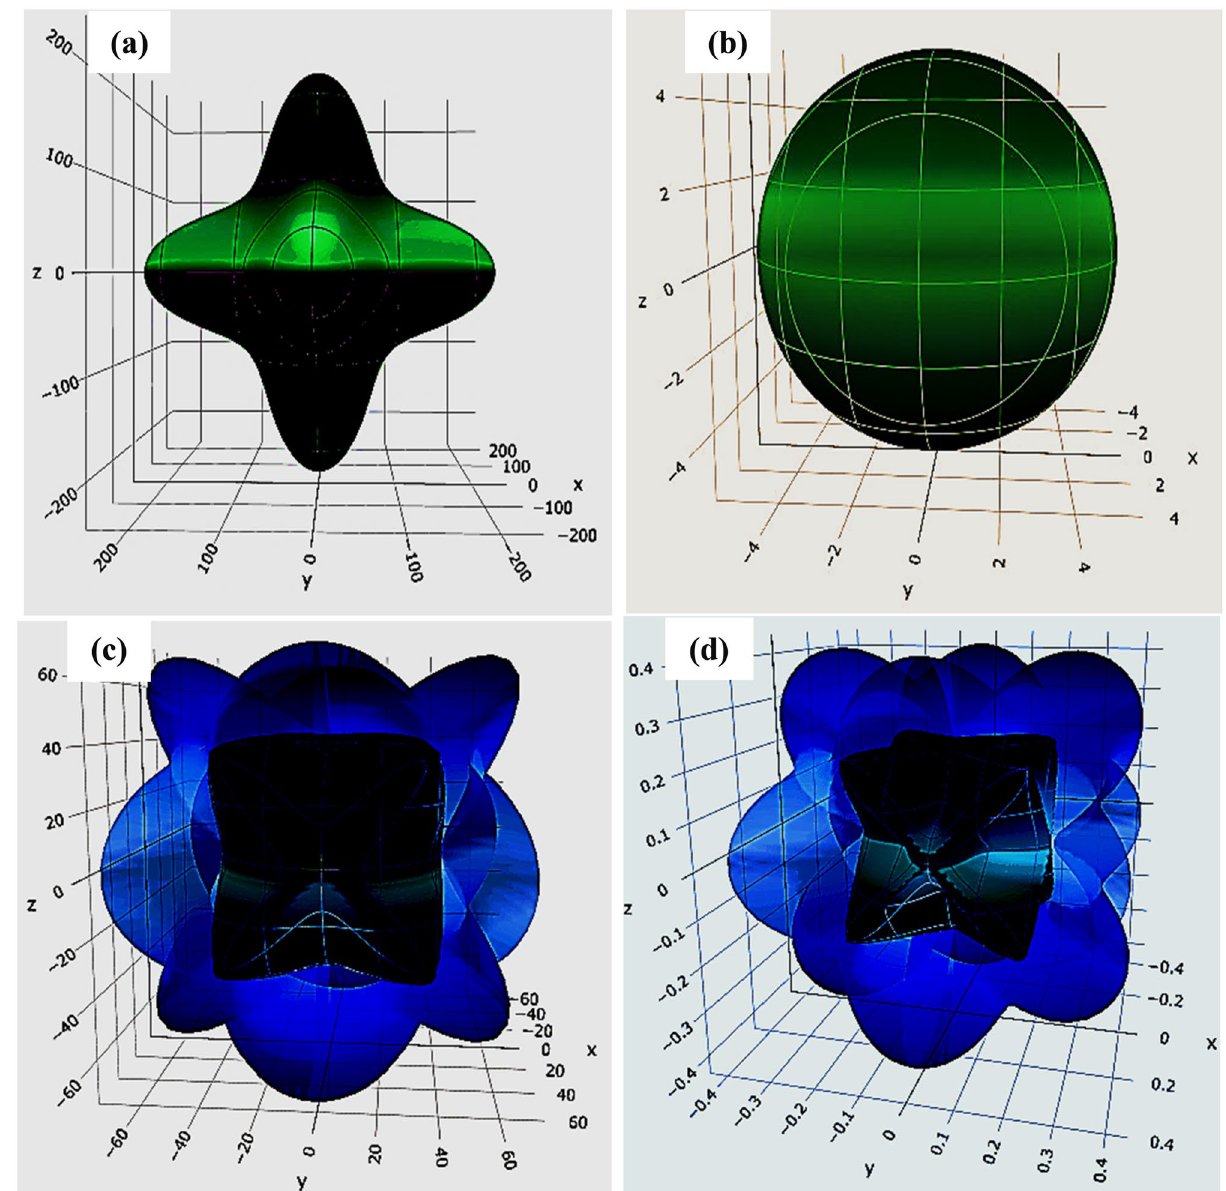
Figure 11. Directional dependence of ( a ) Young’s modulus ( Y ), ( b ) linear compressibility(β), ( c ) shear modulus( G ), and ( d ) Poisson’s ratio( v ) for RbPuO 3